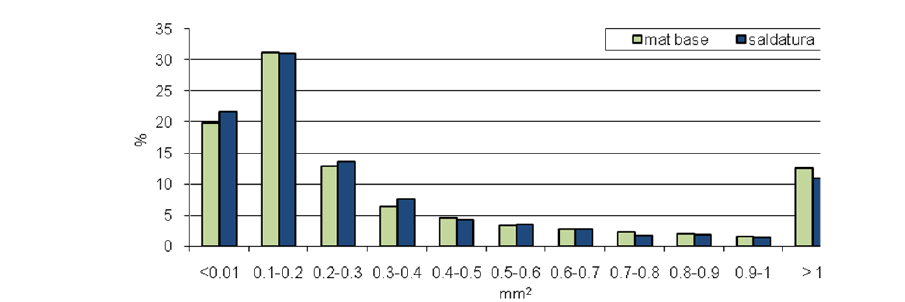
Figura 12: Distribuzione della dimensione delle particelle di rinforzo nel materiale base e nel cordone di saldatura LFW per il composito AMC225xe.